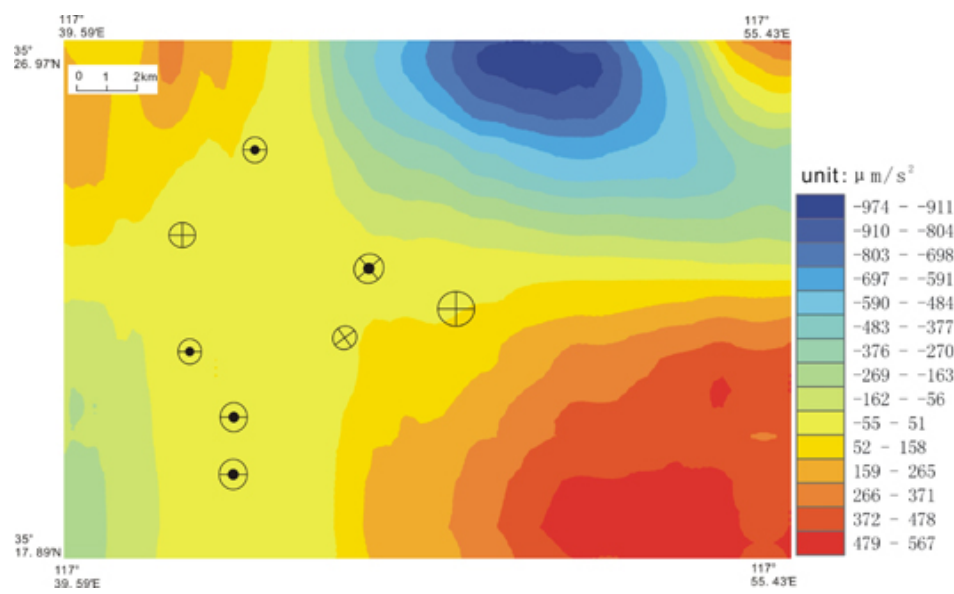
Fig. 4. Reconstructed Image of the 1st and 2nd eigenimages. The legends for the gold deposits see in Fig. 1.